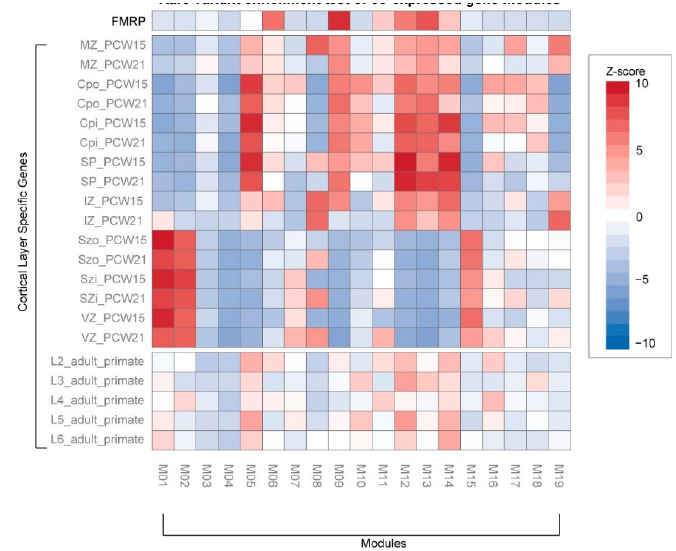
Figure 4. Rare variant enrichment test of co-expressed gene modules. We compared module genes with the FMRP target genes and other genes previously associated with the cortical layer. Cortical layer genes were selected from different laminae: marginal zone (MZ), outer/inner cortical plate (CPo/CPi), subplate (SP), intermediate zone (IZ), outer/inner subventricular zone (SZo/SZi), ventricular zone (VZ), and adult cortical layers 2–6 (L2–6). The heatmap of standardized z-scores (one-tailed binomial test) indicates significance (blue to red) of co-expressed genes modules associated with developmental stages of the brain.